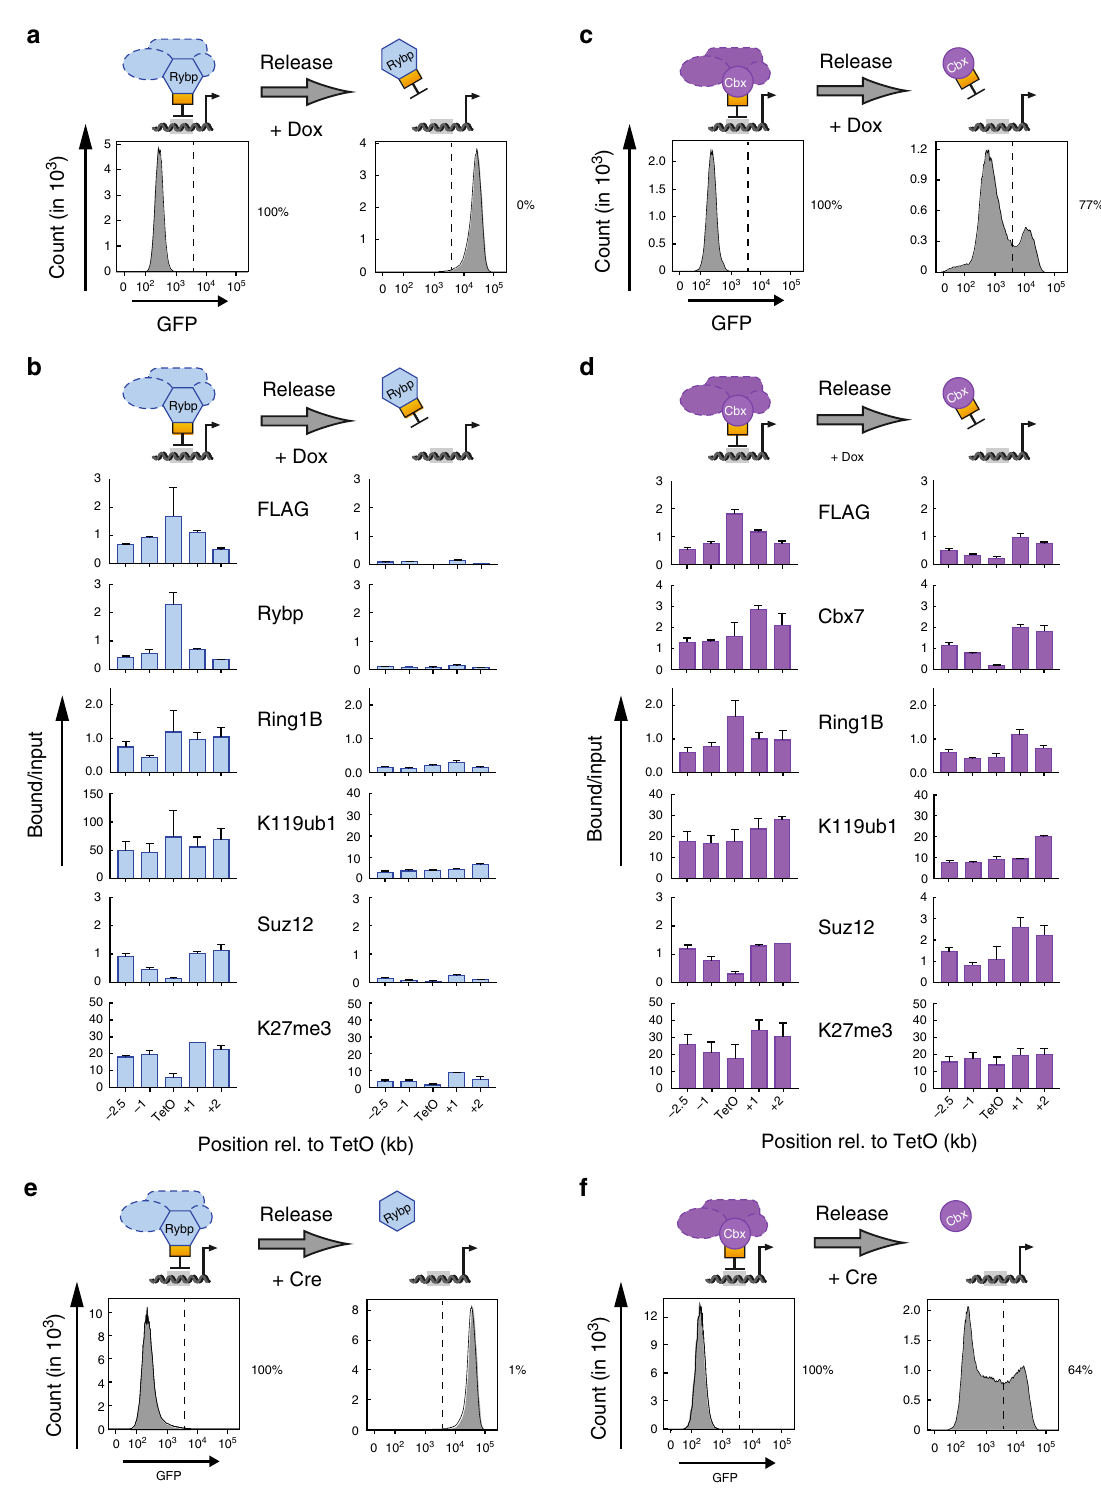
Fig. 2 cPRC1 but not vPRC1 supports propagation of repressive chromatin. a , c Flow cytometry histograms relate GFP expression before and after release of TetR fusion protein recruitment in response to Dox treatment for 6 days. Percentages (%) indicate fraction of silenced cells. b , d ChIP qPCR analyses comparing relative enrichments of FLAG-TetR fusion proteins, PcG proteins and histone modi fi cations before and after 6 days of Dox treatment. ChIP enrichments for H2AK119ub1 and H3K27me3 are normalized to negative control locus (IAP). Data are mean ± SD (error bars) of at least two independent experiments. Source data are provided as a Source Data fi le. e , f Flow cytometry histograms relate GFP expression before and 6 days after genetic release of Rybp and Cbx7 tethering by Cre-mediated deletion of the TetR DNA binding domain. Percentages (%) indicate fraction of silenced